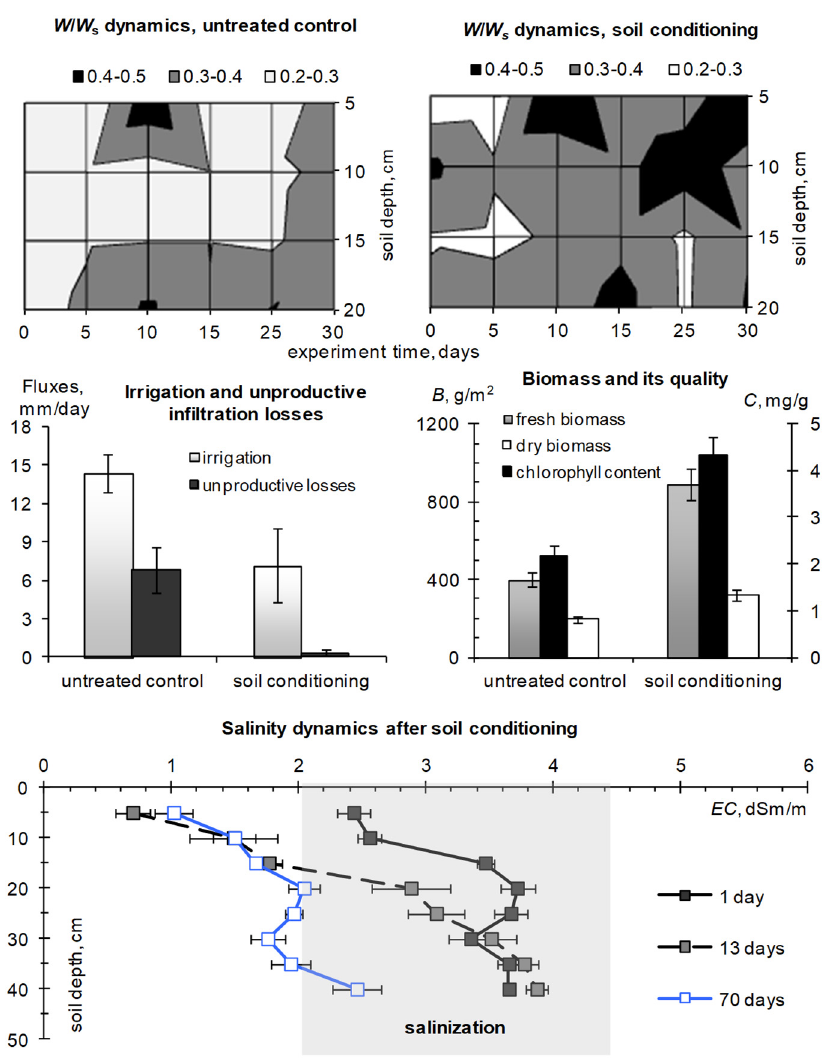
Figure 5. Soil regimes, irrigation, lawn biomass, and its quality under the influence of PAA-gel- forming conditioner (O.A.E. Dubai, 1995).